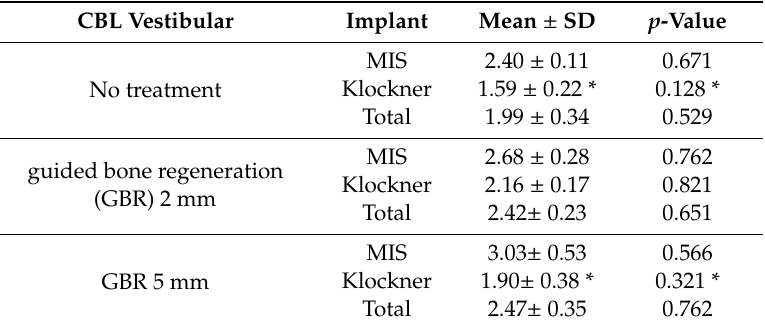
Table 6. Comparison of mean vestibular crestal bone loss (CBL) between three conditions and the two implant groups at Time 2 (3 months after implant